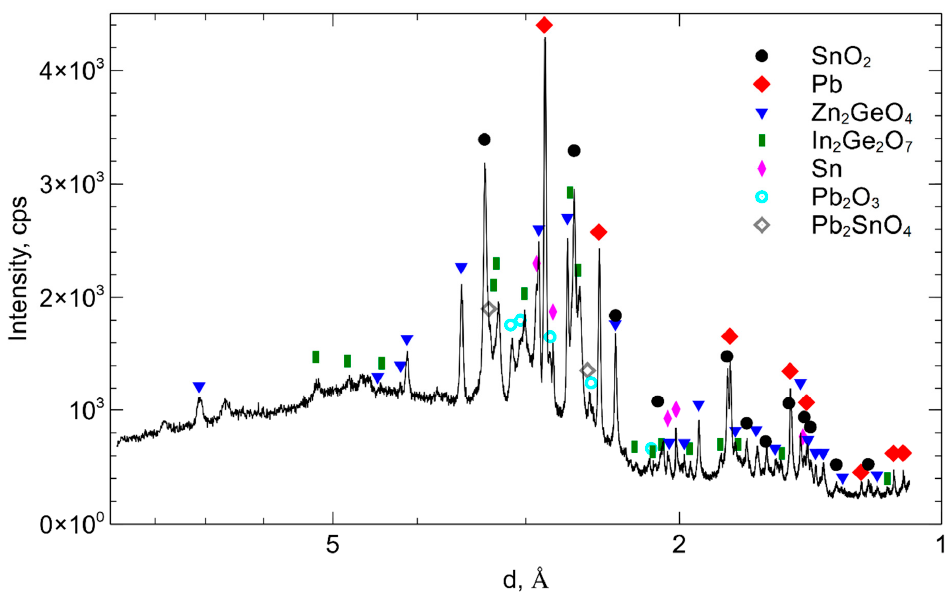
Figure 1. X-ray powder diffraction (XRD) pattern of GeIn dross.